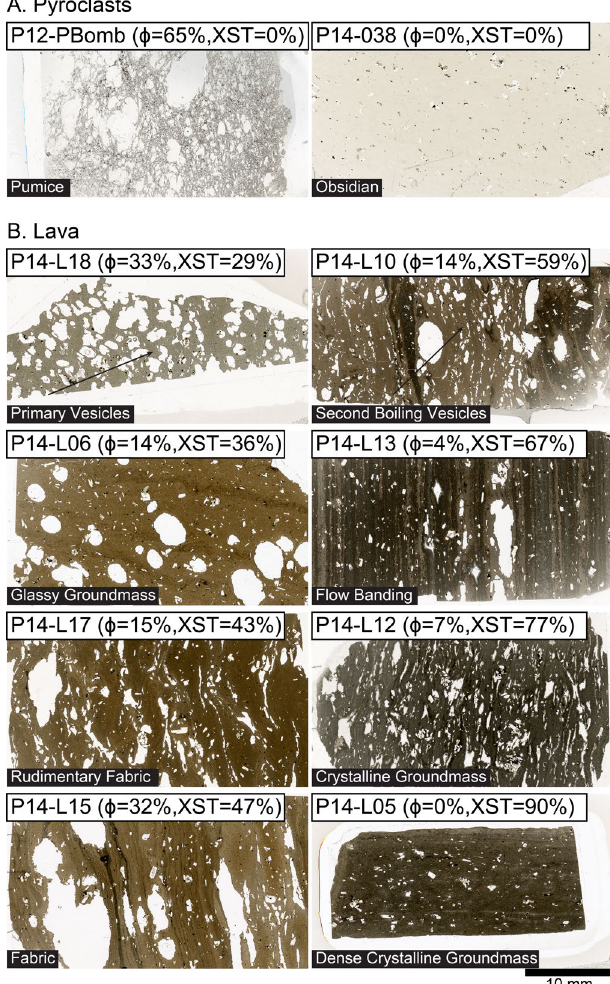
Figure 4: Thin sections of Cordón Caulle [A] pyro- clasts and [B] lava samples, all at the same scale. To- tal porosity ( φ ) and groundmass crystallinity (XST) are shown as percentages, and key features are labelled. ment, with increased flattening of vesicles parallel to microlite-rich flow bands, until the material is avesicu- lar and holocrystalline (in P14-L05). The dense sample P14-L05 is considered to be representative of the ma- jority of the flow volume (e.g. inset to Figure